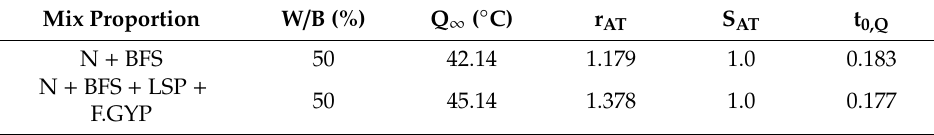
Table 7. Adiabatic temperature rise properties of concrete.